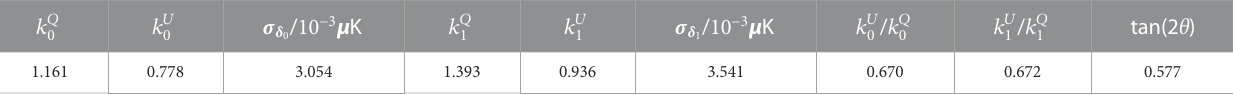
TABLE 1Derived fi ttingparametersfor single pointsource with unknownpolarizationdirectionwhen r =0.023,wherethe subscripts 0and1denotethe ideal and realistic templates, respectively. k Q 0